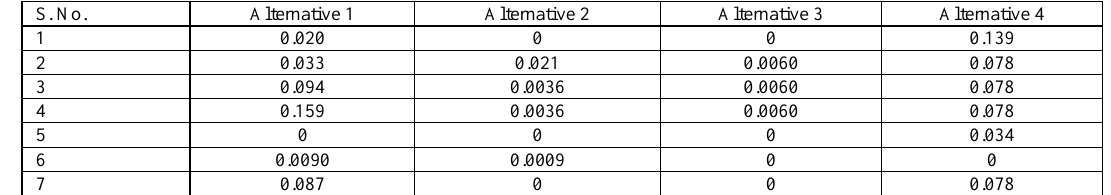
Table 12. Distances of each alternative from positive idle solution